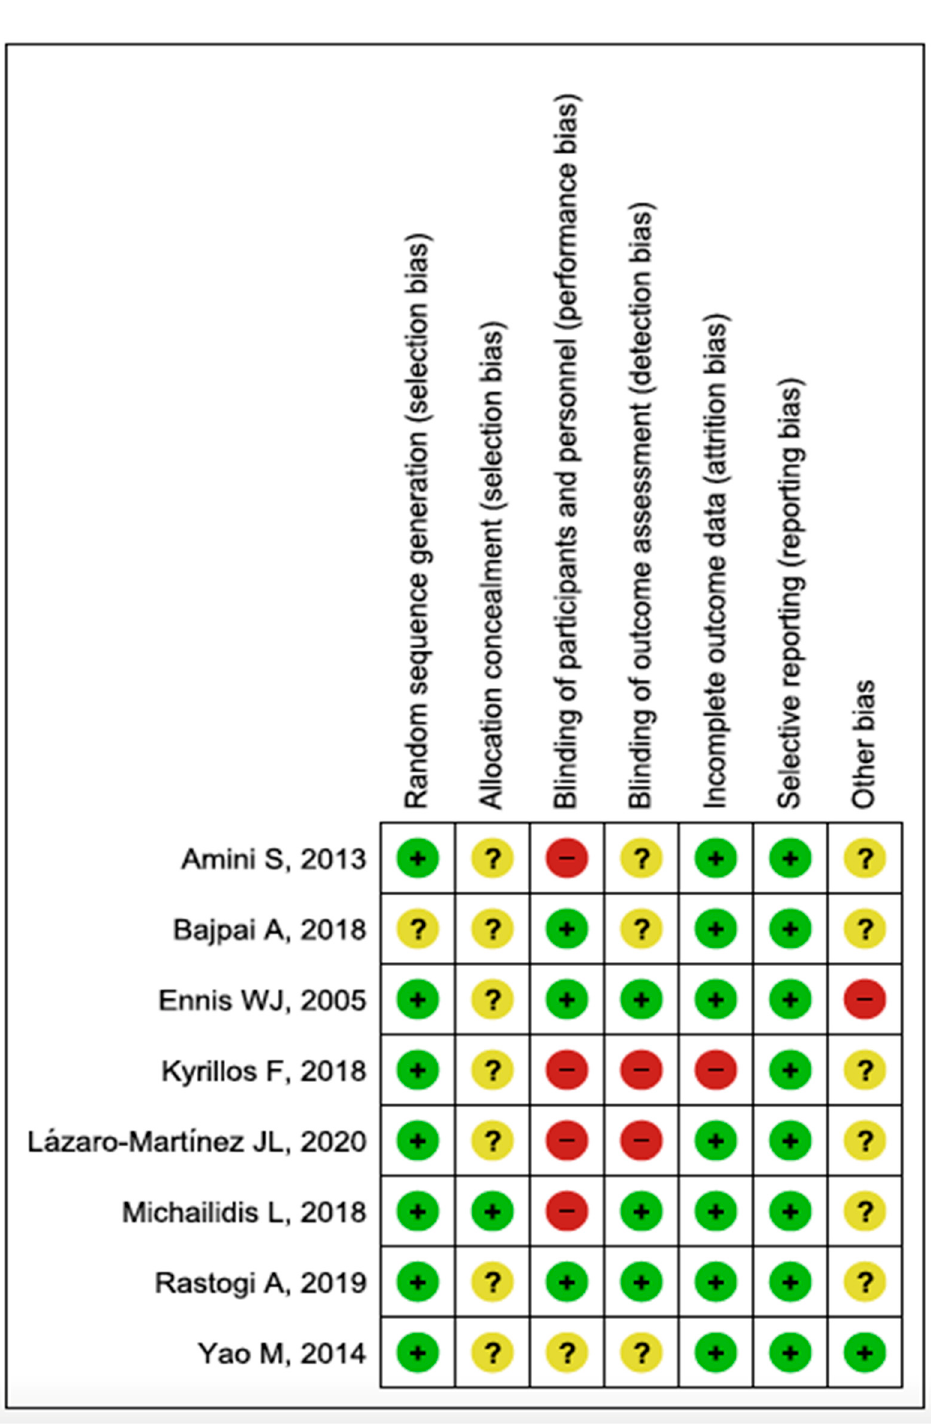
Figure 3. Risk of bias summary: Review authors’ judgments about each risk of bias item for each included study. Green: Low risk of bias. Yellow: Unclear risk of bias. Red: High risk of bias.